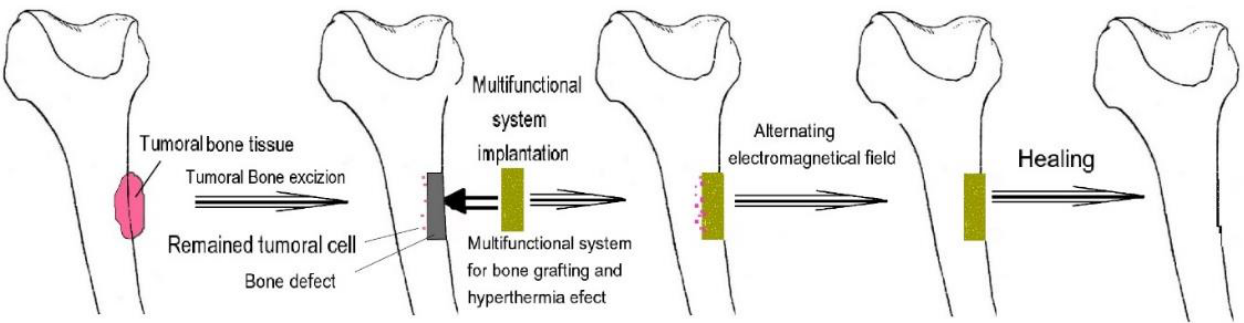
Figure 5. The procedure of treating osteosarcoma using multifunctional materials (with the kind permission of Springer [92]).